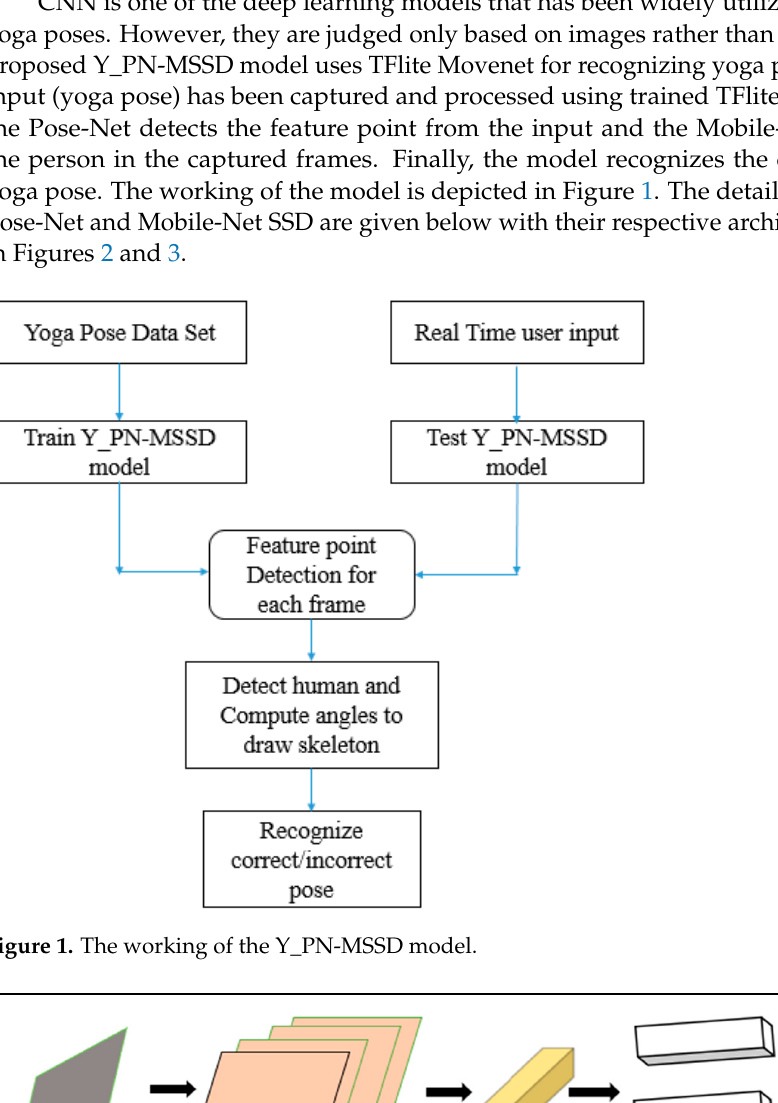
Figure 3. Mobile-Net SSD architecture. 3.1. Pose Net It is a deep learning framework that identifies the positions of joints in images or video sequences involving human body movement. The joints are considered as key points, which are indexed by Part ID with a range from 0.0 to 1.0, with 1.0 as the highest score. Among different layers, soft-max activation function, which is at the last layer, has been replaced with a series of fully linked layers. Figure 1 depicts its high-level architecture. The performance of this model [22] depends and differs completely on the device and output stride. Because of this, the model works on posture positions in the entire scale of captured images, regardless of the size. Here, an encoder, localizer and regressor act as three components. The encoder generates the encoding vector, which contains the features of the input image represented as a 1024-dimensional vector. The localizer generates a vector with localized features. Finally, a regressor is used to perform regression on the final position using two linked layers in the model. 3.2. Mobile-Net SSD It is a model that computes the input for making bounding box and categorize them from an input which is also called as object detection model. Single Shot Detector (SSD) in this model uses Mobile-Net [22] to achieve optimized object detection, which will work faster on mobile devices. This model contains offset values (cx, cy, w, h) where cx is the input, cy is the output and w is the weight and h is the score. The scores contain confidence values for 20 objects, and the background value is reserved as 0. Here, the extracted features are used as an arbitrary backbone and the resolution is calculated by reducing the extra layers. Then, this model computes the resolution by concatenating six levels of output. Finally, by utilizing non-maximum suppression (nms), the bounding boxes are filtered out. For a better understanding of the interface, users should first read the manual instruction (guide) of how the YogGuru-Ai works and how efficiently the pose can be performed. The user first needs to select the pose according to their benefit and need. The user should then face the camera. For proper functioning and to obtain good accuracy of